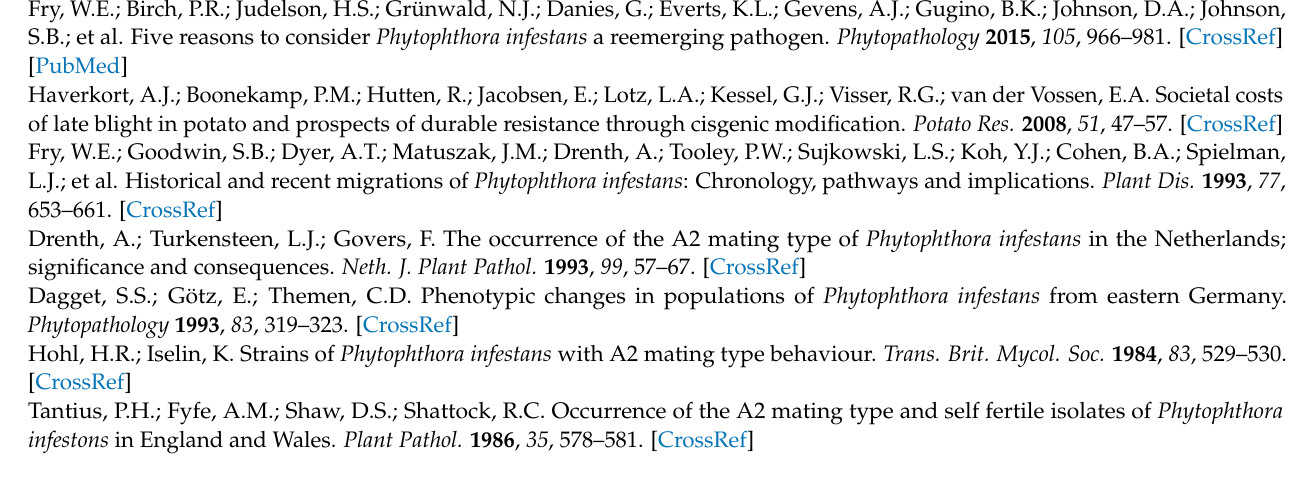
Figure S7: Minimum spanning network (MSN) inferred from simple sequence repeat (SSR) markers of P. infestans (clone corrected) according to (a) locations, (b) years, and (c) agricultural management practices. Each node represents multilocus genotypes (MLGs) and the size is proportional to the number of individuals sharing the same SSR allele profile. The thickness of the lines represents the Bruvo’s genetic distance between two nodes (the further the genetic distance the lighter the color and thinner the line). Figure S8: A bar plot of clone corrected data showing the population membership probability assignments of P. infestans against their original populations for (a) locations, (b) years, and (c) agricultural management practices. Bars of the same color represent the likelihood of the same genetic cluster based on analysis of the single sequence repeat marker data. Bars of mixed colors are admixed individuals/isolates. Figure S9: Neighbor-net phylogenetic tree to access population pattern (clone corrected) on isolate collection at different (a) locations, (b) years, and (c) agricultural management practices. The clusters are color-coded. Table S1: Allele frequencies of SSR markers in 141 P. infestans isolates collected in Pskov region from 2010–2013. Table S2: Clone corrected standardized index of association (r ¯ d) within isolates of P. infestans , sampled at different locations, years, and agricultural management